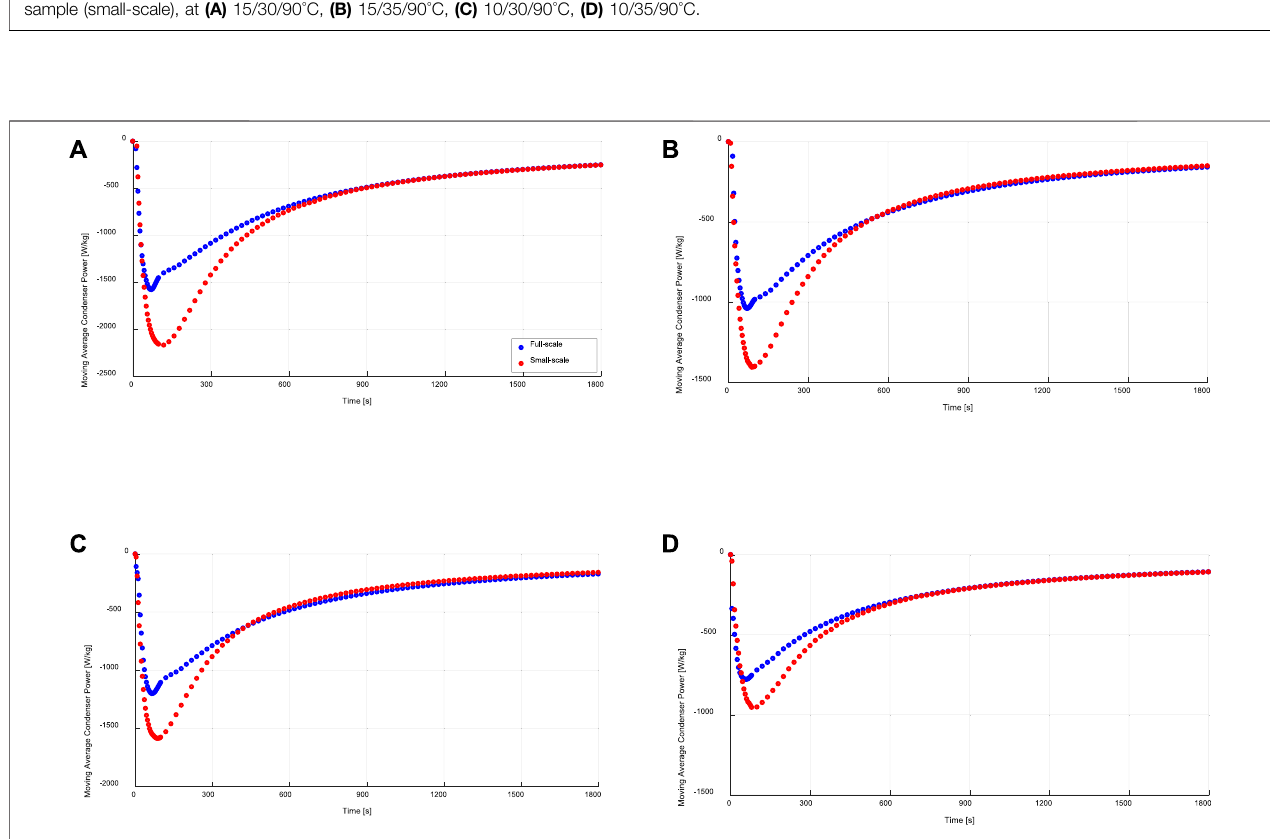
FIGURE10| Speci fi cmovingaveragecondensationpoweroftheevaporator/condenserunit(full-scale)andthatestimatedfromthekineticresultsoftheadsorbent sample (small-scale), at (A) 15/30/90 ° C, (B) 15/35/90 ° C, (C) 10/30/90 ° C, (D) 10/35/90 ° C.